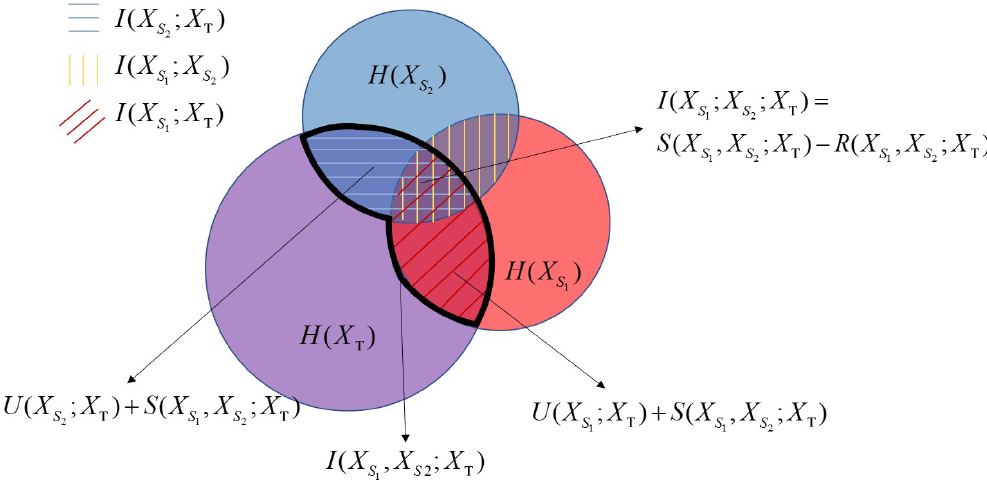
Figure 2. Venn diagram representation of the information theory concepts considering two sources, i.e., X S X T . Areas of the circles are proportional to Shannon entropy (i.e., H(X S mutual information (i.e., I(X S X S ; X T ) ) corresponds to the region delimited by the thick black curve. Unique (i.e., U(X S 2 X S ; X T ) ), and redundant (i.e., R(X S 2 X T )